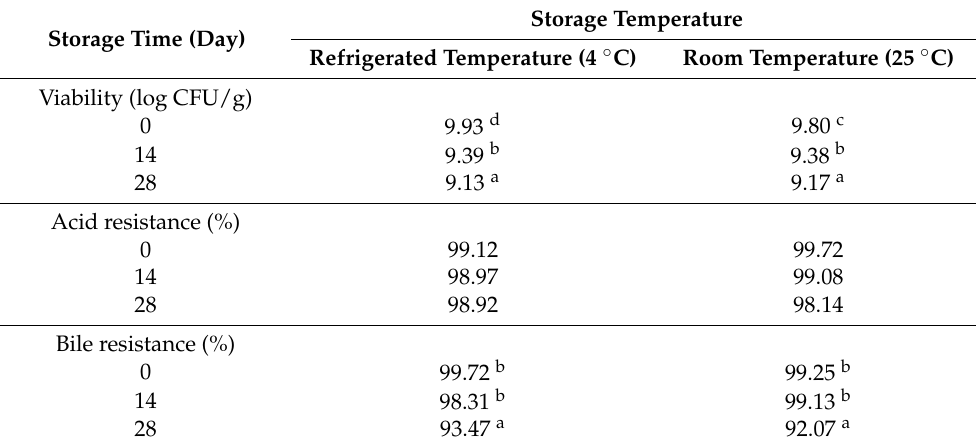
Table 1. Viability and bile and acid tolerance of Lactobacillus fermentum InaCC B1295 in CMFH-OPEFB at various temperatures for 28